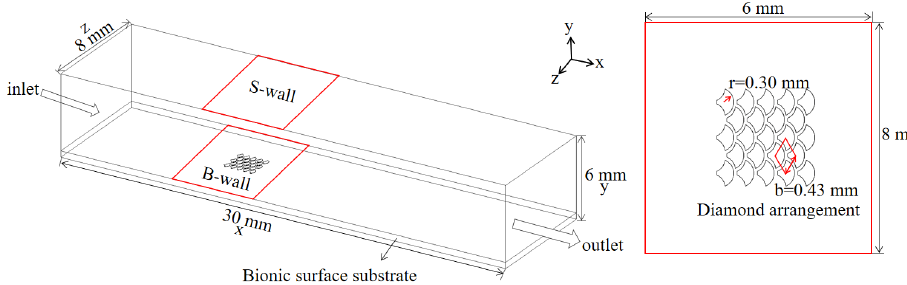
Figure 8. Computational domain.